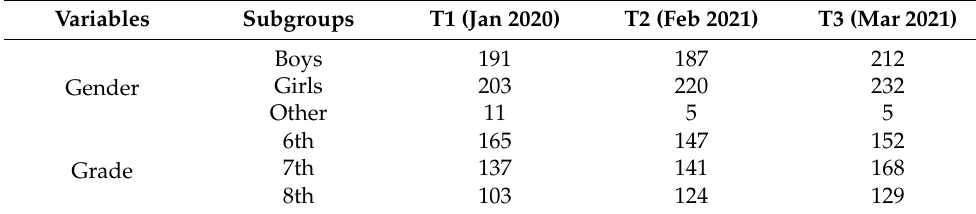
Table 1. Demographic characteristics of the sample across three time